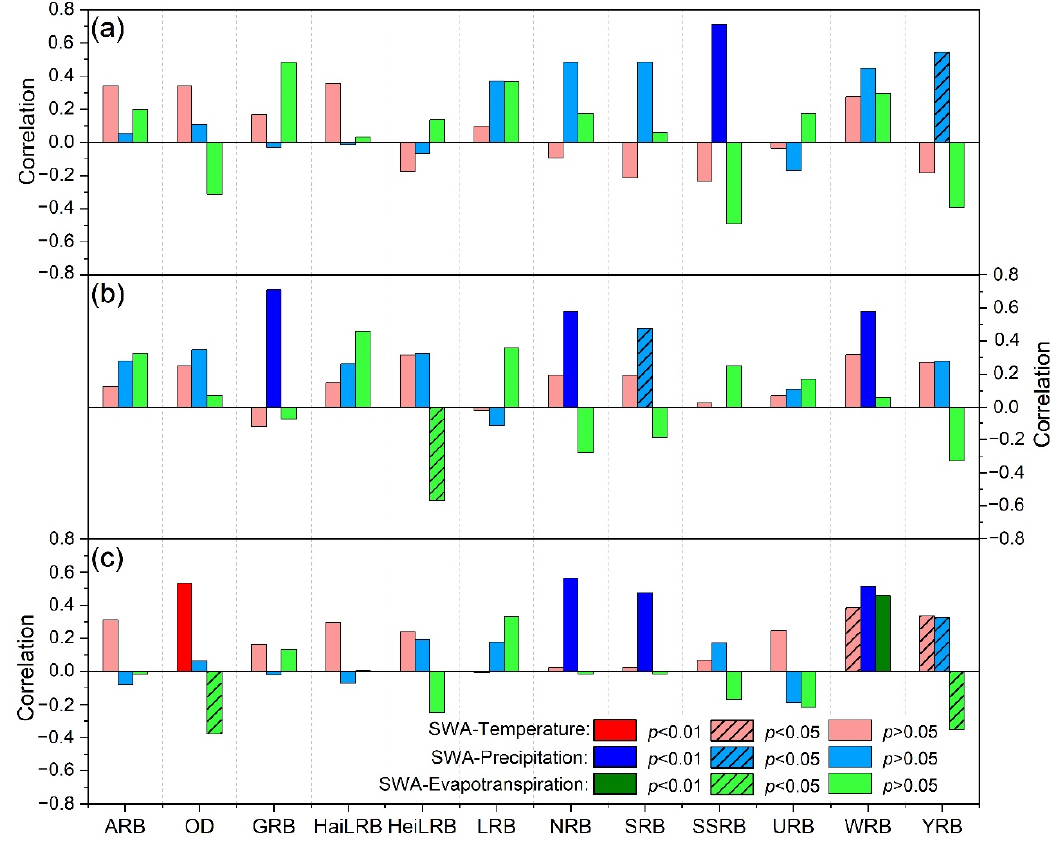
Figure 9. Correlations between SSWA and temperature, precipitation, and evapotranspiration in the basin at different times: ( a ) the correlation between SSWA and three climate factors for